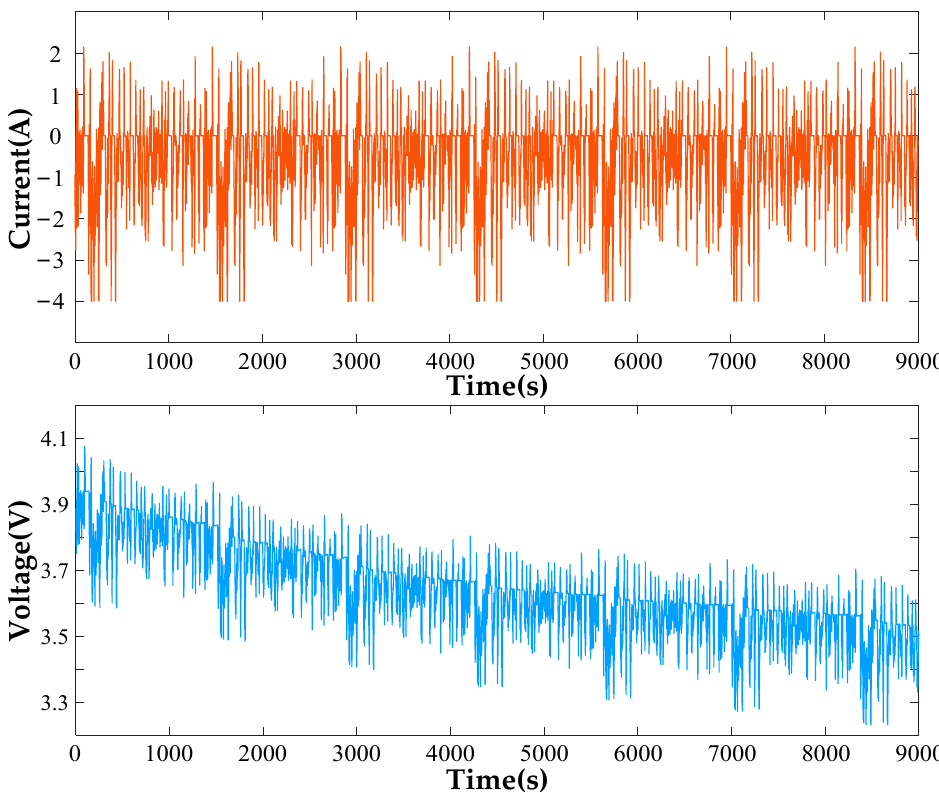
Figure 6. The current and terminal voltage of the lithium battery from FUDST.